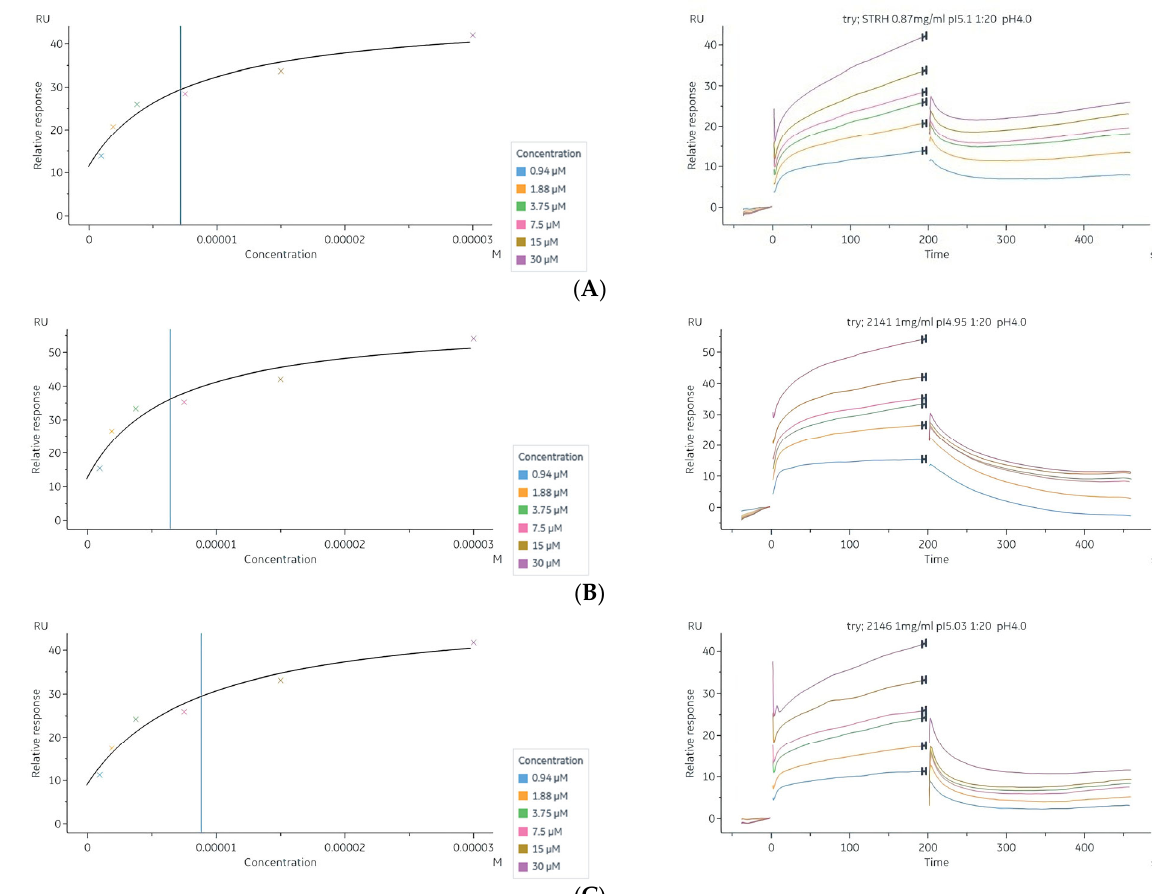
Figure 6. Surface plasmon resonance (SPR) analysis of the interaction between Tryptanthrin and three potential targets. ( A ) StrH KD = 7.16 × 10 − 6 . ( B ) SP_2141 KD = 6.43 × 10 − 6 . ( C ) SP_2146 KD = 8.82 × 10 − 6 . The KD values were determined from the ratio between the kinetic rate constants (k a k d − 1 ).